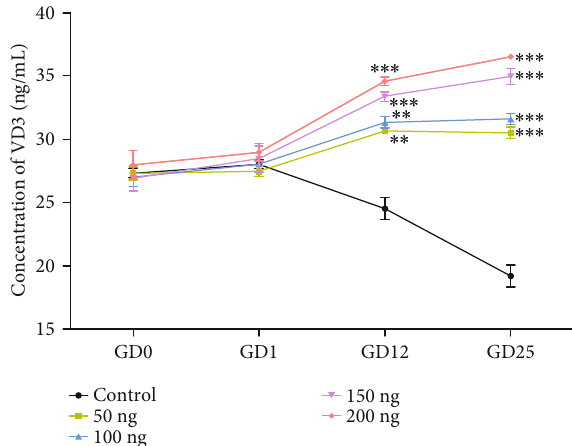
Figure 1: The response of the serum VD3 levels of pregnant mice to di ff erent doses of VD3. There was a positive dose-dependent manner between the supplementation time and the concentration of VD3. Values are mean ± SEM ( n = 5 ). GD: gestation day. ∗∗ P < 0 : 01 vs. control and ∗∗∗ P < 0 : 001 vs.